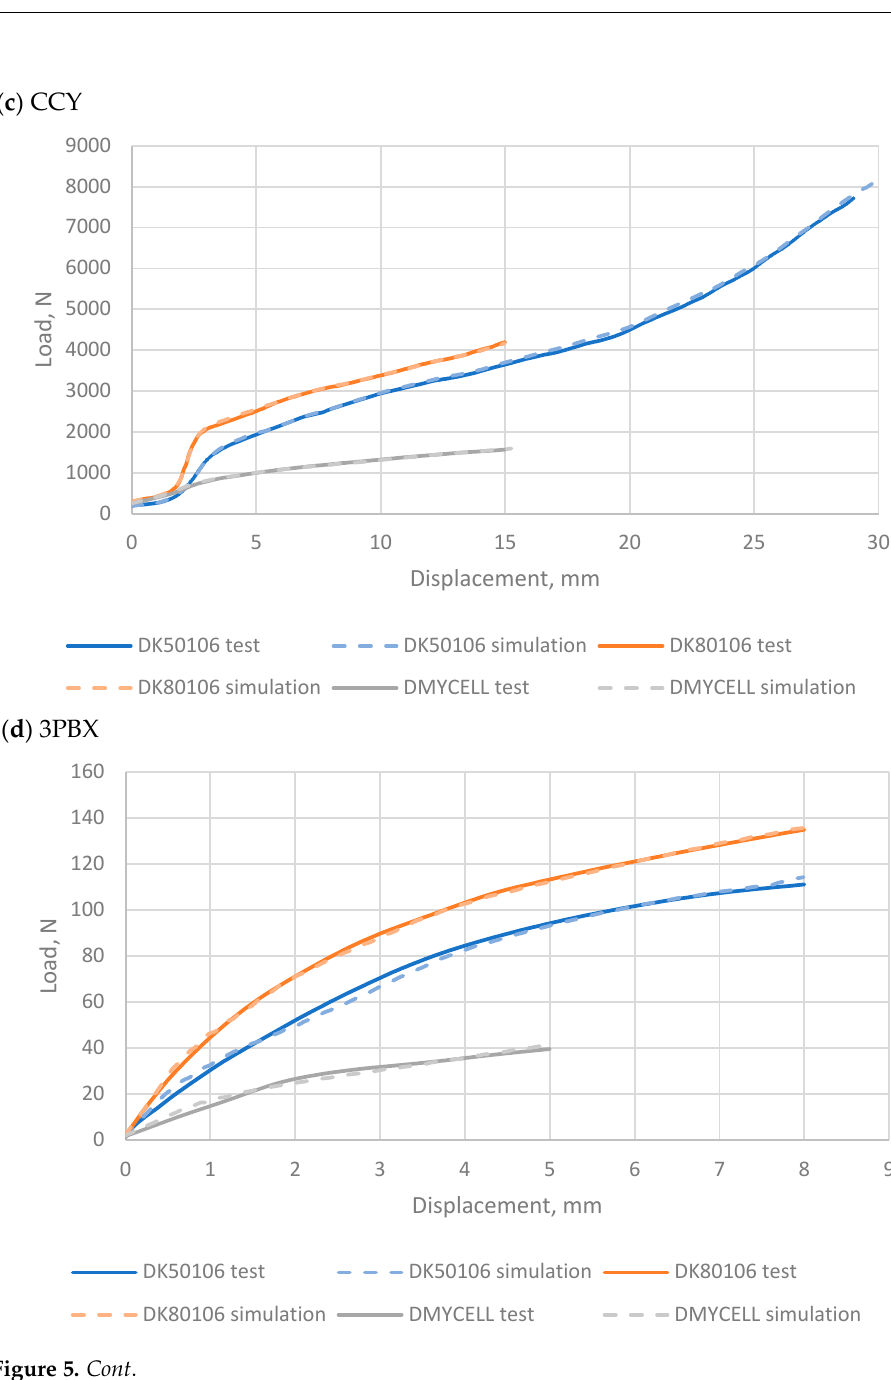
Figure 5. Comparison of simulation results from the calibrated models with test data for ( a ) Lat ‐ eral compression in Z ( b ) Confined compression in X, ( c ) Confined compression in Y, ( d ) 3 ‐ point bend around X axis, ( e ) 3 ‐ point bend around Y axis. All tests conducted at 50% SoC. For each cell type and load ‐ case considered the calibrated force ‐ displacement re ‐ sponse matched well with average physical test response, deviations from the average physical test response being contained within the boundaries of the measured test to test variation. The greatest variation was found in the yielding/onset of buckling in confined compression load case. Figure 6 shows the FEM model of the Dow Kokam SLPB 50106100 cell subject to the three main load cases of lateral compression, in ‐ plane confined compression and three ‐ point bend. The original and deformed meshes are visible, demonstrating the stability of the model.